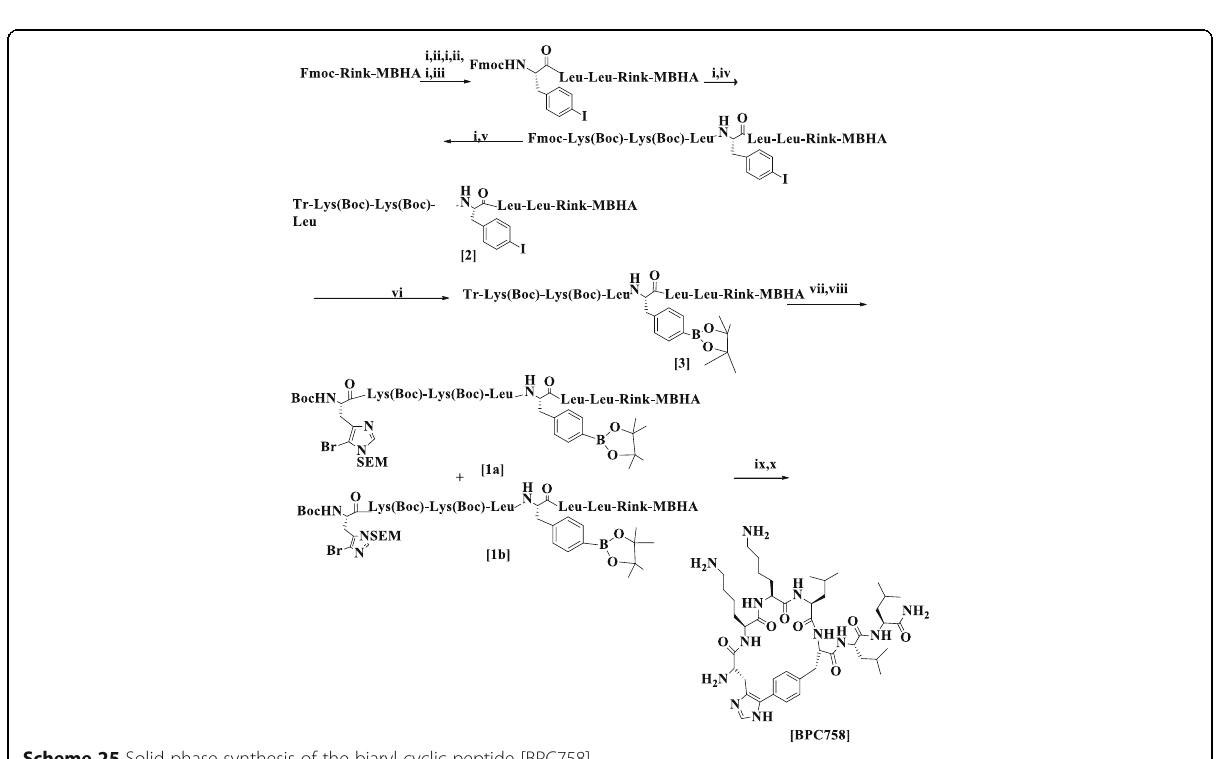
Scheme 25 Solid-phase synthesis of the biaryl cyclic peptide